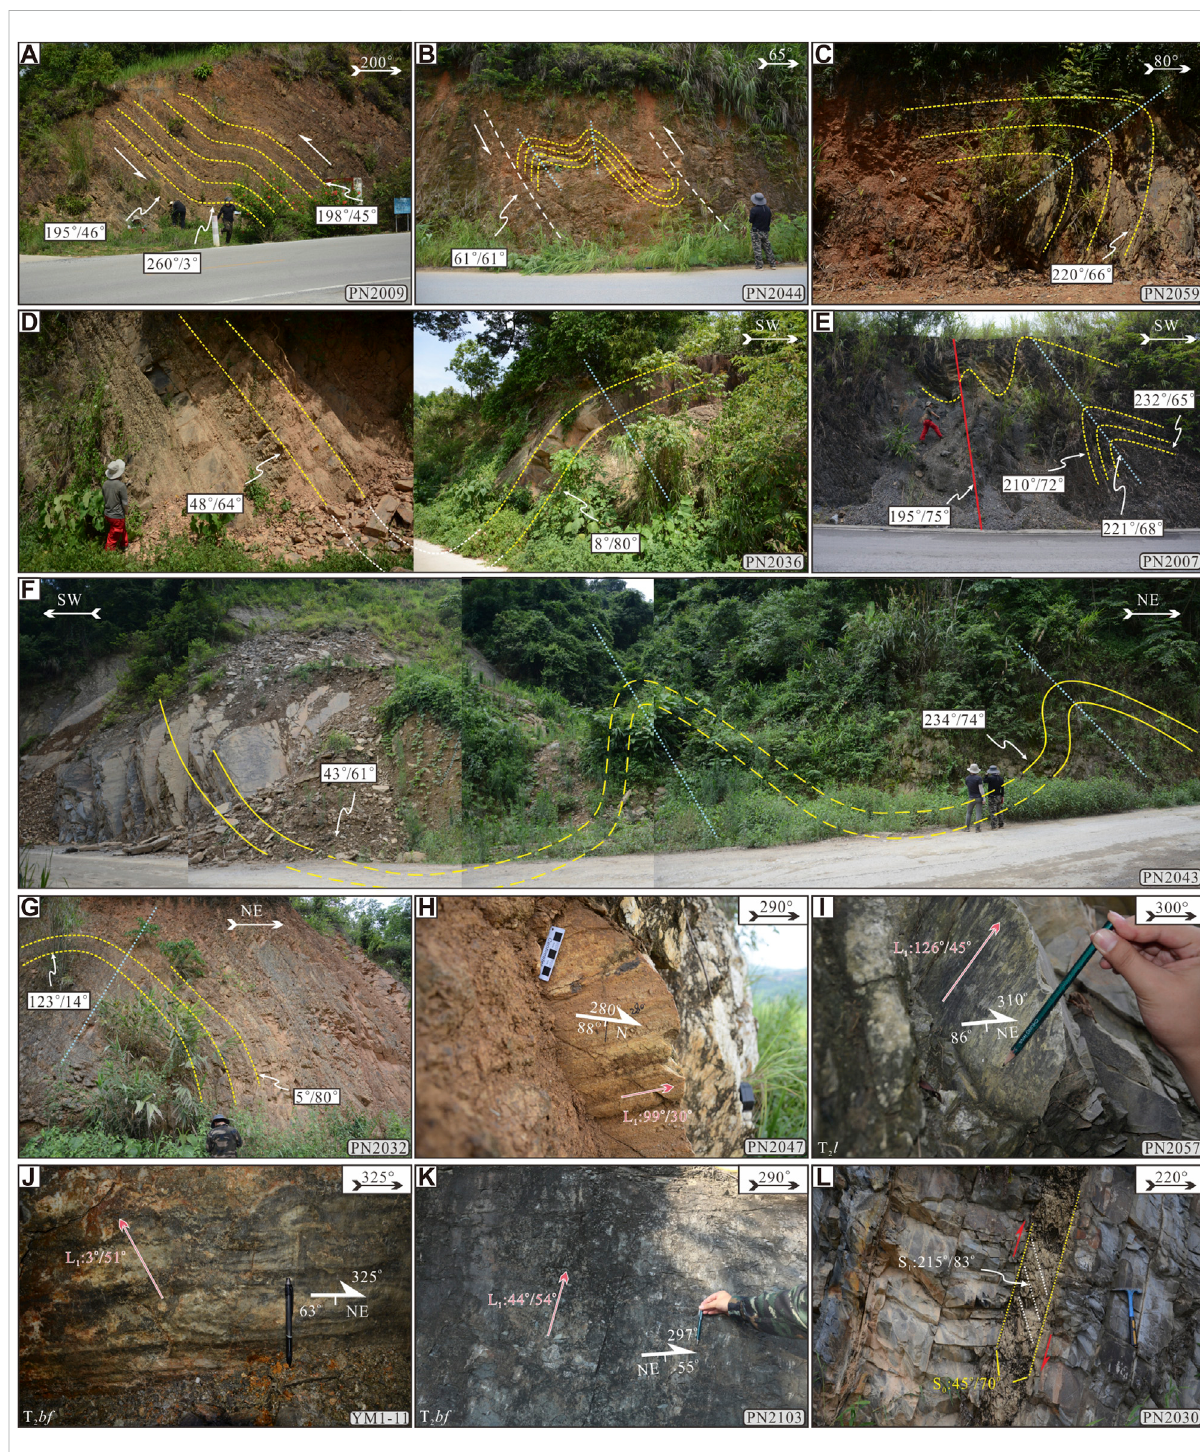
FIGURE 2 Fieldphotographs ofmainstructuresdevelopedintheD 1 deformationintheYFTB. (A) ThefoldinthesiltstoneoftheTriassicBaifengFormation at PN2009 indicating a top-to-the-NE movement. (B) Asymmetric fold in the siltstone of the Triassic Lanmu Formation at PN2044 indicating a top- to-the-SWmovement. (C) AsymmetricfoldinvolvingtheTriassicLanmuFormationintheTianlinsynclinoriumatPN2059indicatingatop-to-the-NE movement. (D) Asymmetric fold in the siltstone of the Triassic Baifeng Formation at PN2036 showing a top-to-the-NE movement. (E) NE- verging thrustsand fault-related folds involving siltstoneofthe Triassic Baifeng Formation intheTianlinsynclinorium atPN2007 indicating atop-to- the-NEmovement. (F) AsymmetricfoldsinvolvingthesiltstoneoftheTriassicLanmuFormationintheTianlinsynclinoriumatPN2043demonstrating a NE – SW oriented shortening. (G) Asymmetric fold in Triassic siltstone in bedding siltstone of the Triassic Baifeng Formation at PN2032 indicating a top-to-the-NE movement. (H) Strike-slip striations on the NWW-striking fault plane indicating a NE – SW compression. (I) Sinistral striations and mineral steps in the siltstone of the Triassic Baifeng Formation at PN2057 showing a sinistral strike-slip movement. (J) Thrusting striations on the siltstoneoftheTriassicBaifengFormation inthePingnaundergroundtunnelatYM1-11indicatingaNE – SWcompression. (K) Thrustingstriationsand mineral steps on the siltstone of the Triassic Baifeng Formation at PN2103 indicating a NE – SW compression. (L) Steeply-dipping cleavage (S 1 ) and structural transposition in the Triassic weakly competent argillaceous siltstones at PN2030 indicating an interlayer shearing. Frontiers in Earth